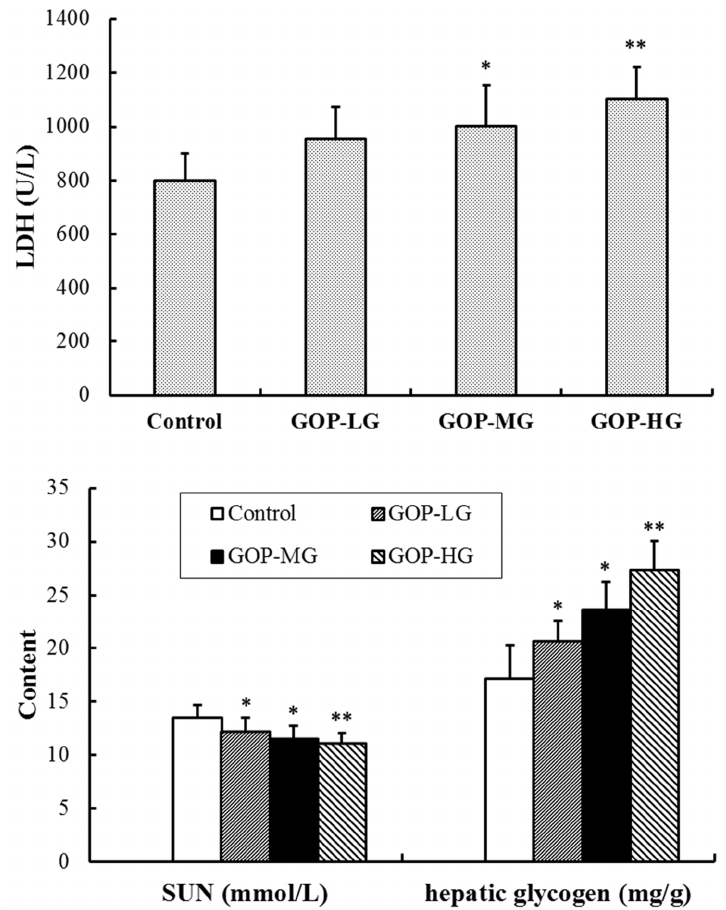
Figure 2. Effects of GOP on lactate dehydrogenase (LDH), serum urea nitrogen (SUN), and hepatic glycogen content in mice. Data were presented as means ± SD ( n = 15). * p < 0.05, ** p < 0.01 versus